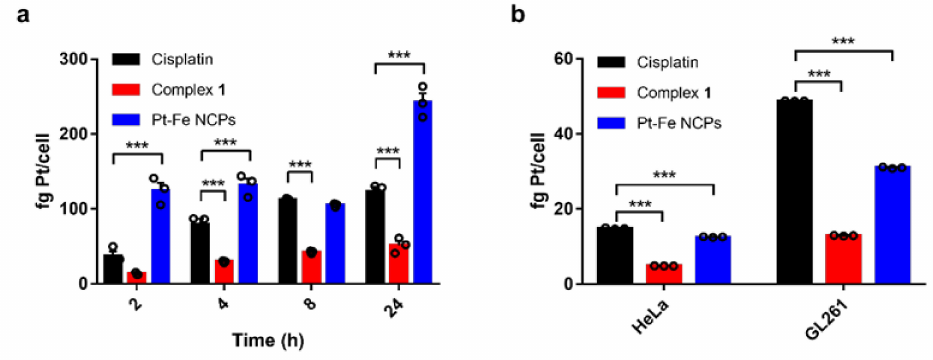
Figure 4. Cellular uptake determination of ( a ) total platinum content of GL261 cells after treatment with cisplatin, complex 1 and Pt-Fe NCPs at a concentration of 10 µ M Pt along with time, and ( b ) DNA-bound Pt in HeLa and GL261 cells after exposure to cisplatin, complex 1 , and Pt-Fe NCPs for 24 h at a Pt concentration of 10 µ M. Data represented as mean ± SE of three independent experiments. *** stands for p <